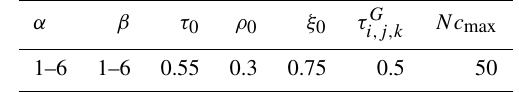
Table 2. Parameter value of ant colony